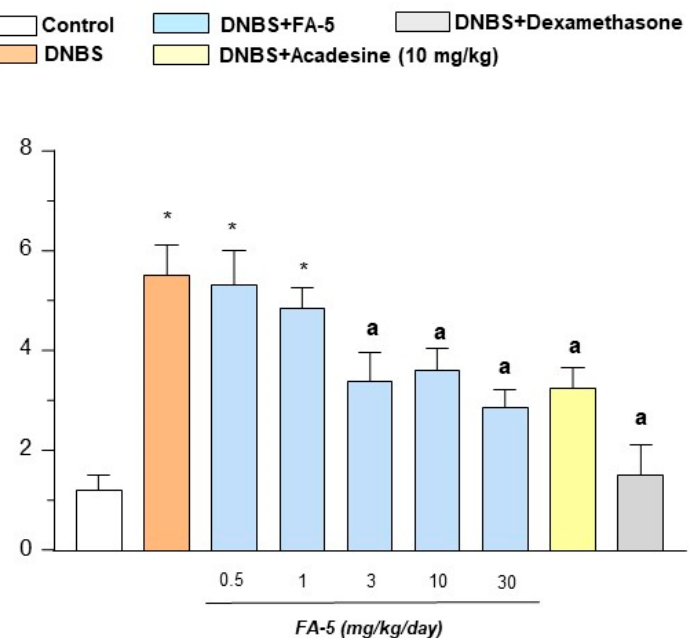
Figure 4. Microscopic damage score estimated for colon in rats under normal conditions or with DNBS-induced colitis, either alone or after treatment with FA5 (0.5–30 mg/kg/day), acadesine (mg/kg/day), or dexamethasone (1 mg/kg). Each column represents the mean ± standard error of the mean (SEM) ( n = 8). * p < 0.05, significant difference vs. control group; a p < 0.05, significant difference vs. DNBS group.